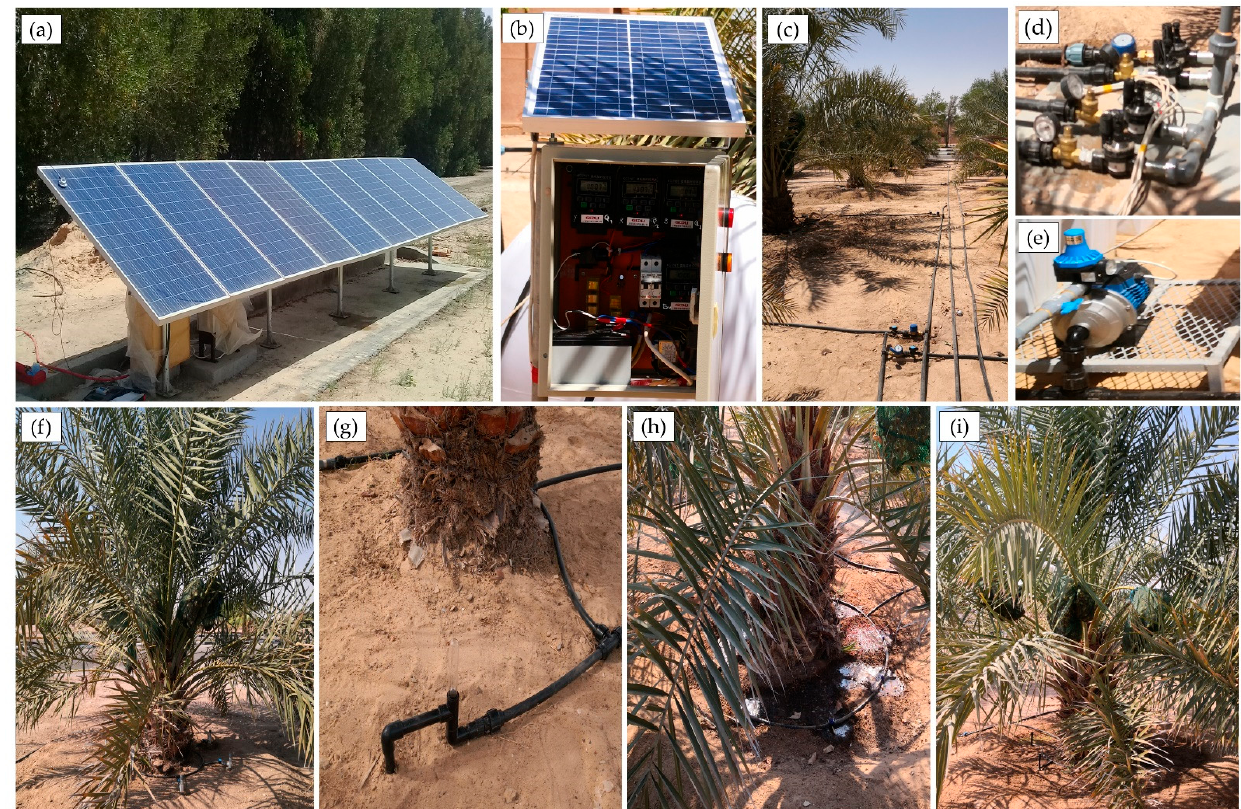
Figure 2. Experimental setup of the solar PV and irrigation systems: ( a ) PV array toward south with a tilt angle of 30°, ( b ) irrigation control unit with small PV system, ( c ) irrigation network, ( d ) solenoid valves and pressure regulators, ( e ) irrigation water pump with an automatic regulator, ( f ) subsurface irrigation system (SIS), ( g ) subsurface drip irrigation system (SDIS), ( h ) drip irrigation system (DIS), ( i ) bubbler irrigation system (BIS).